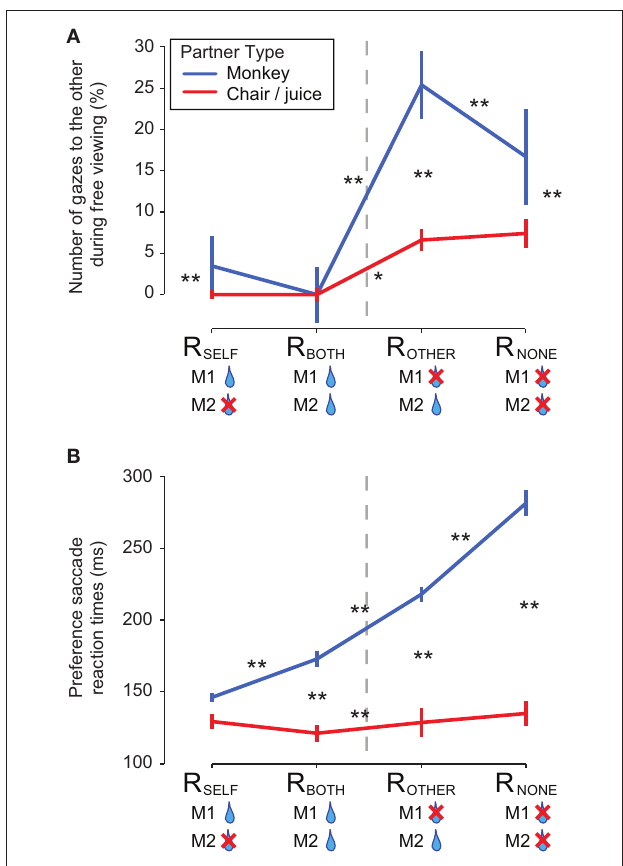
Figure 5 | gaze behavior reflects the internal social deliberation process. (A) The frequency of gaze shifts (%; median ± SEM of individual sessions; 64 M1–M2 sessions, and 13 M1–C/J sessions) toward the face region of M2 (or toward the juice tube and the bottle on control trials) during the free-viewing period (after choosing a reward option) of the preference task. (B) Saccade reaction times (RTs; median ± SEM of individual sessions; 64 M1–M2 pairs, and 13 M1–C/J pairs) for choosing different reward outcomes in the choice task. Asterisks indicate significance in (A,B) : * p < 0.05; ** p < 0.005 by Wilcoxon sign rank test across same partner types, and Wilcoxon rank sum test across different partner types. Dashed vertical lines distinguish Self/Both and Other/None